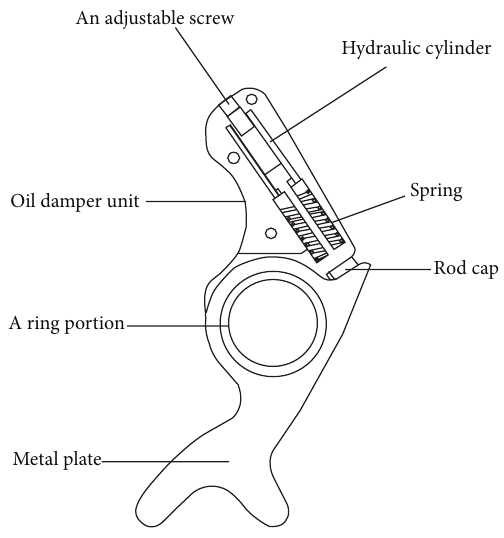
Figure 2: A schematic diagram of the ankle joint of AFO with oil damper